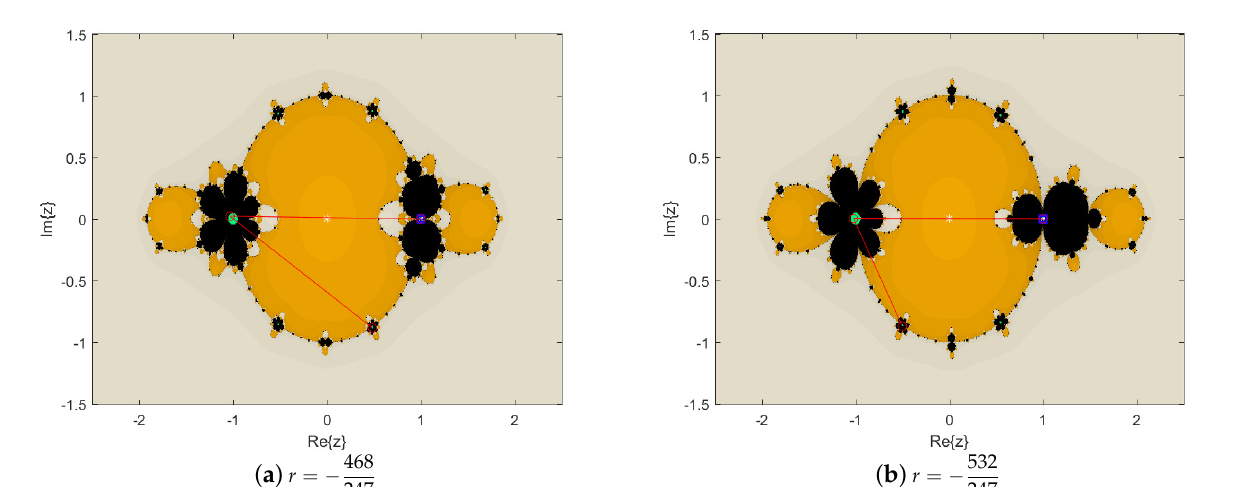
Figure 10. Dynamical plane of parameters that make Ex 1 a neutral